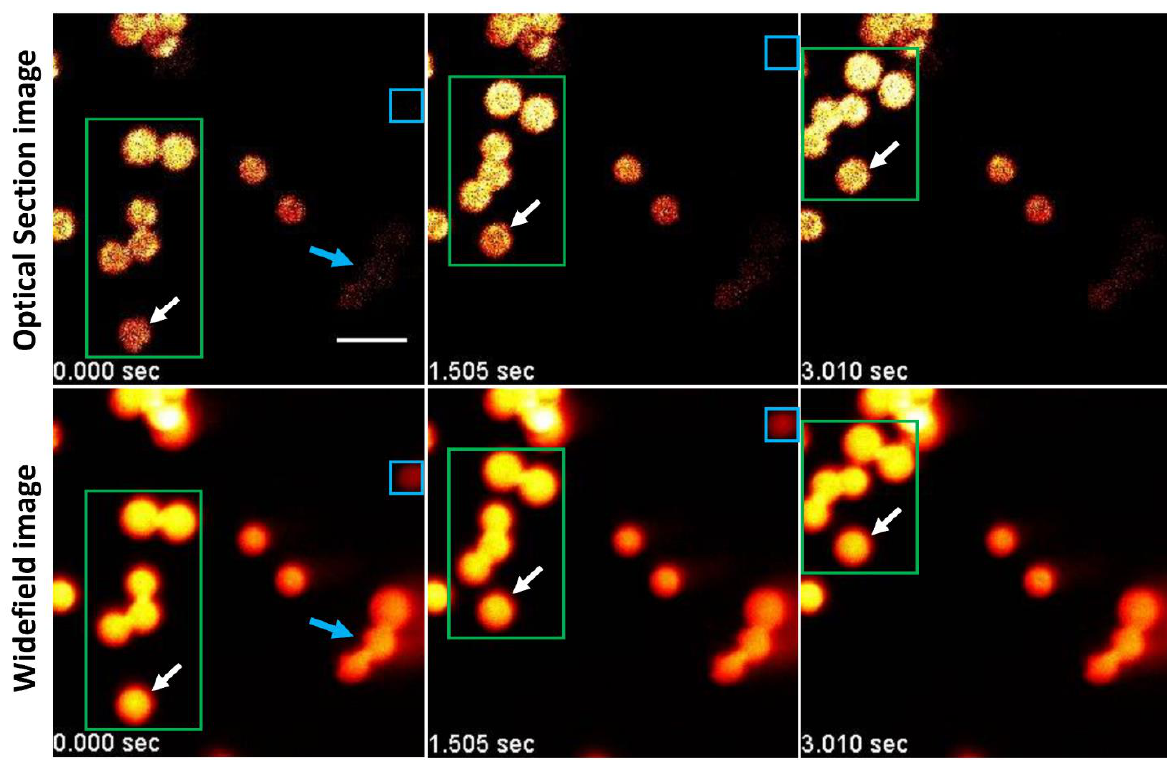
Figure 5. Fast imaging of moving fluorescent microspheres; blue arrows point to the stationary microspheres, and different squares point to the moving microspheres, scale bar: 30 µm. Table 1. Acquisition raw frame rate and one optical-sectioning SIM frame rate according to different ROIs.